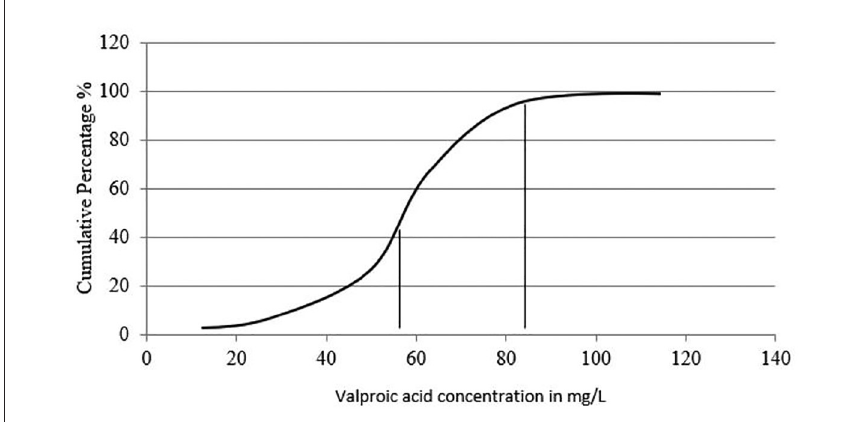
Figure 1. Cumulative percentage (%) of patients in the good control group